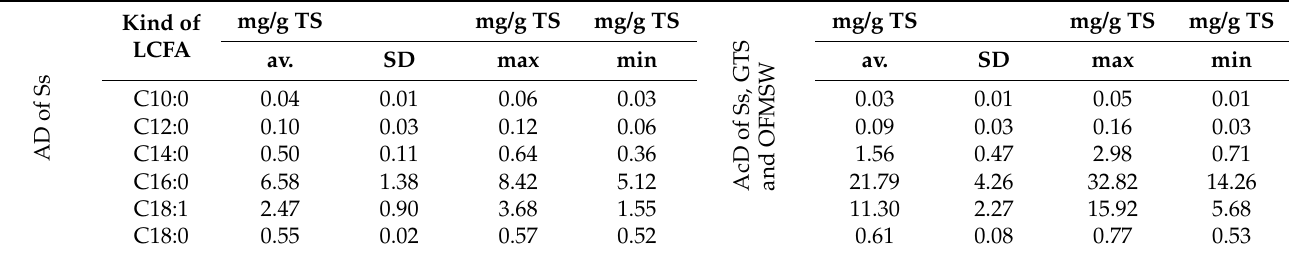
Table 3. Long Chain Fatty Acid concentration in the digestated sludges (based on Grosser et al. [6]).